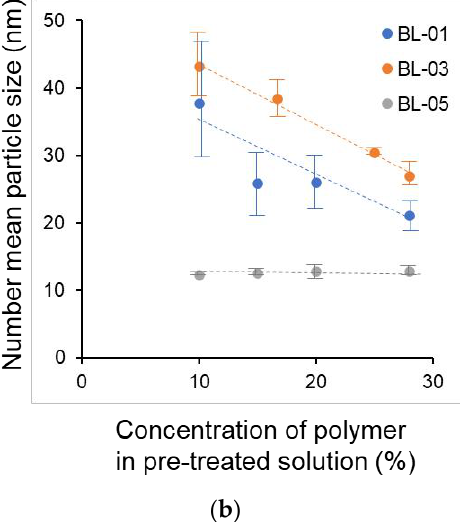
Figure 8. ( a ) Transparency at 600 nm and ( b ) particle size (number mean) of BL-01, BL-03 and BL-05